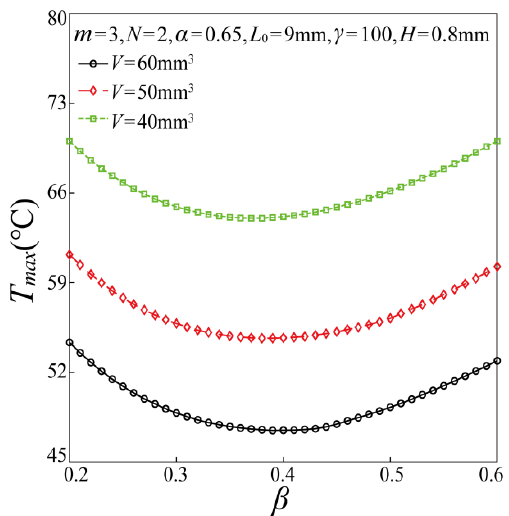
Figure 6. Effect of β with different V on the maximum temperature of the chip.